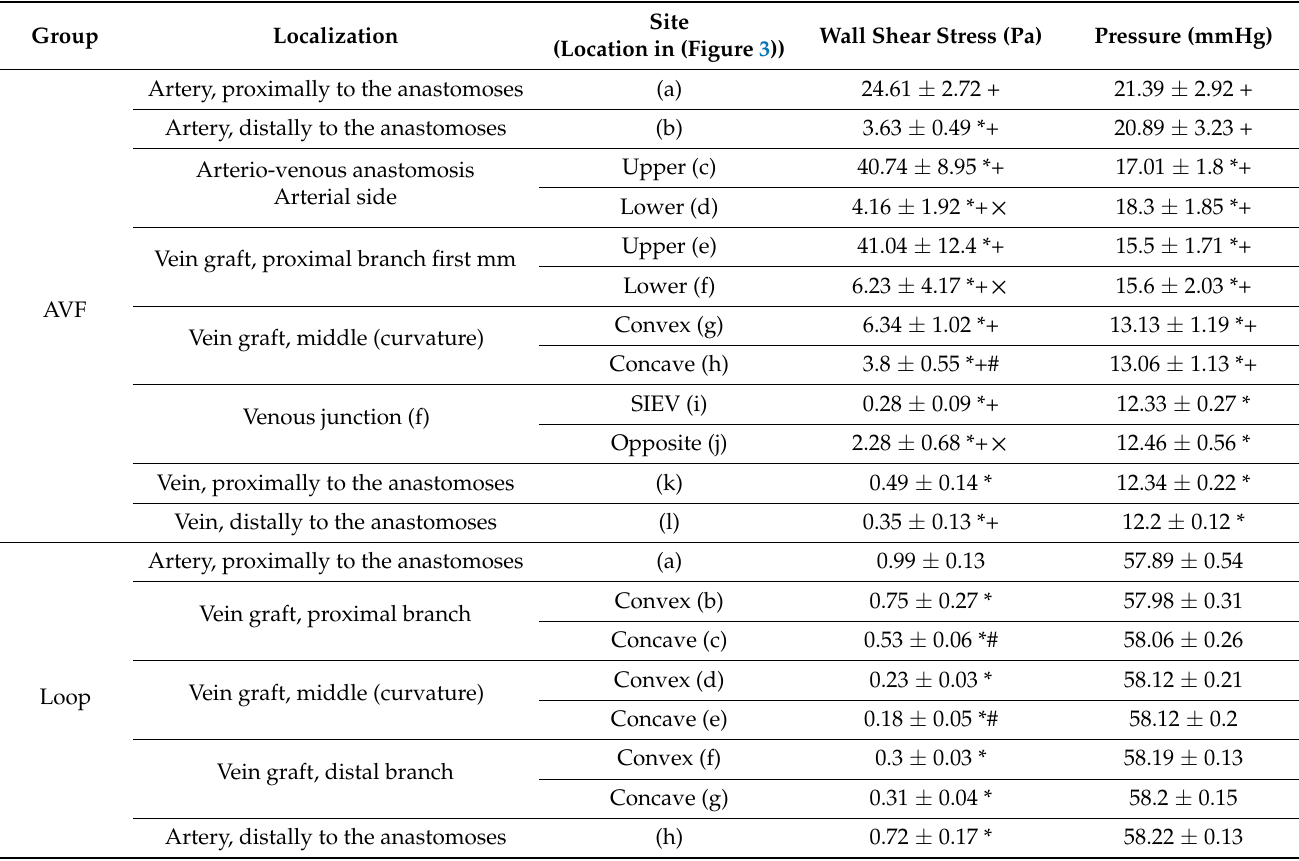
Table 2. The 3D flow simulation data (wall shear stress (Pa) and pressure (mmHg)) at various sites of the loop-shaped fistulas or interpositioned grafts in the AVF and Loop groups. The 3D flow simulation was performed on the vessel molds taken and prepared in the fifth postoperative